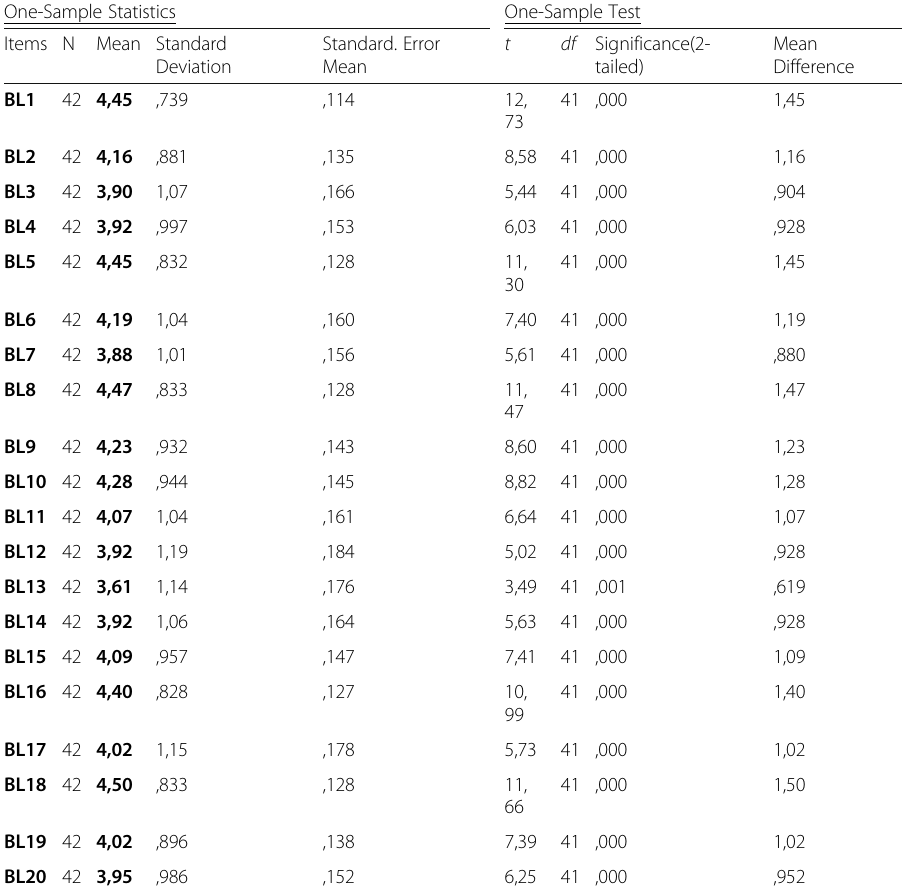
Table 6 One sample t -test for blended learning environment One-Sample Statistics